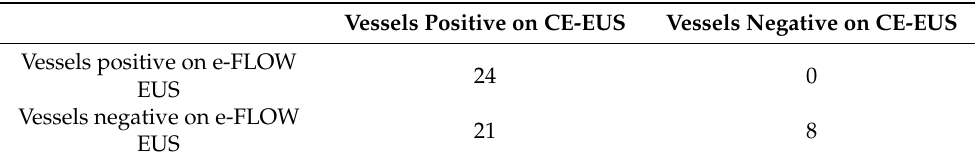
Table 3. Correlation between visualization of vessels in pancreatobiliary lesions between DFI-EUS and CE-EUS. Vessels Positive on CE-EUS Vessels Negative on CE-EUS Vessels positive on DFI-EUS 41 0 Vessels negative on DFI-EUS 4 8